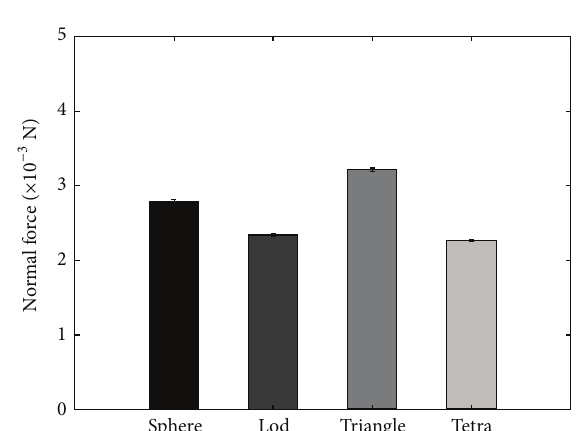
Figure 6: Contact force in normal